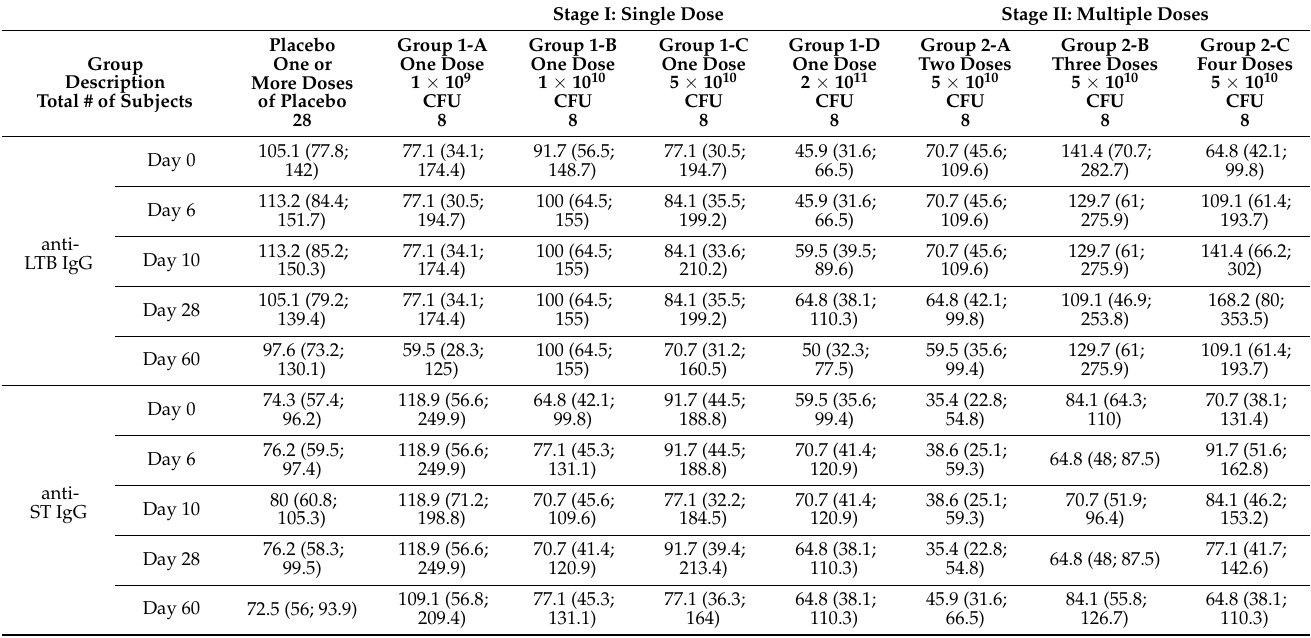
Table A2. Cont. Stage I: Single Dose Stage II: Multiple